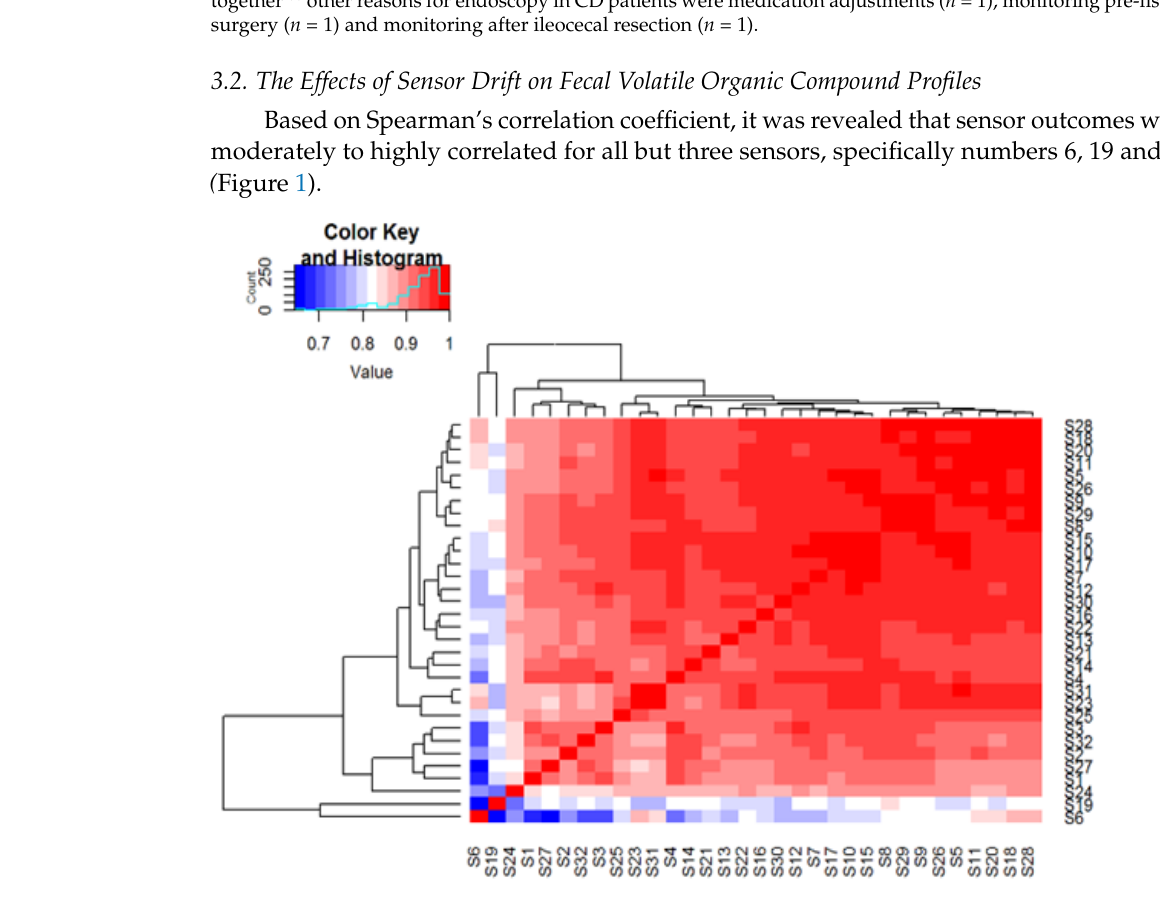
0 (0) Table 1: Abbreviations: n , number; SD, standard deviation; CD, Crohn’s Disease; UC, Ulcerative Colitis; IBD, Inflammatory Bowel Disease; NA, not applicable. * For seven controls and two CD patients, multiple indications were noted; for two UC patients, indication was insufficiently re- ported †Surveillance after CRC, for polyps and Lynch taken together ** other reasons for endoscopy in CD patients were medication adjustments ( n = 1), monitoring pre-fistula surgery ( n = 1) and mon- itoring after ileocecal resection ( n = 1).